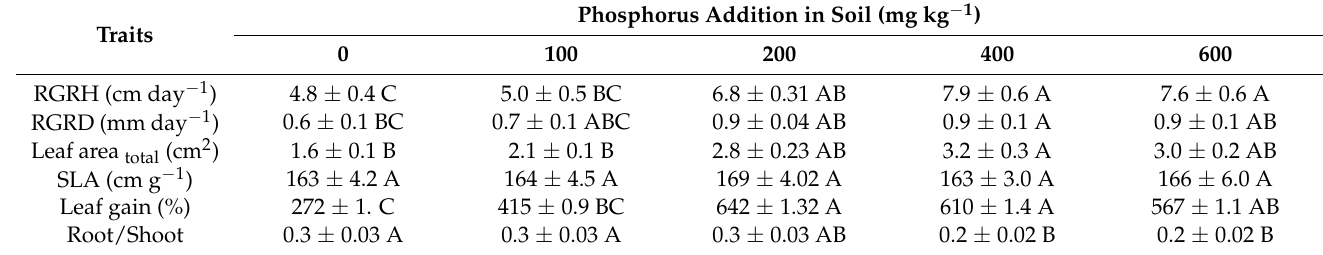
Table 1. Influence of soil phosphorus availability on growth and morphological traits of Bertholletia excelsa saplings. The relative growth rates in height (RGRH), diameter (RGRD), and specific leaf area (SLA). Different letters on the same line indicate significant differences between the means by the Tukey test at a 0.05 probability